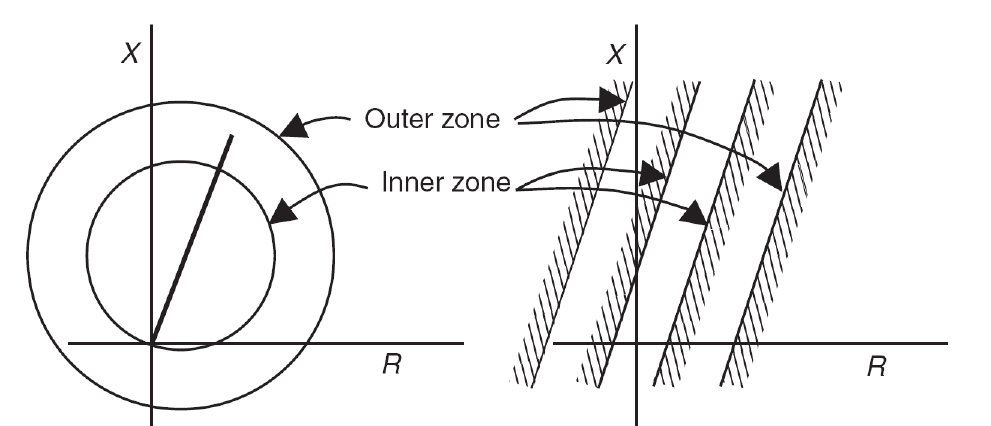
Figure 2. Out of Step Relay characteristics